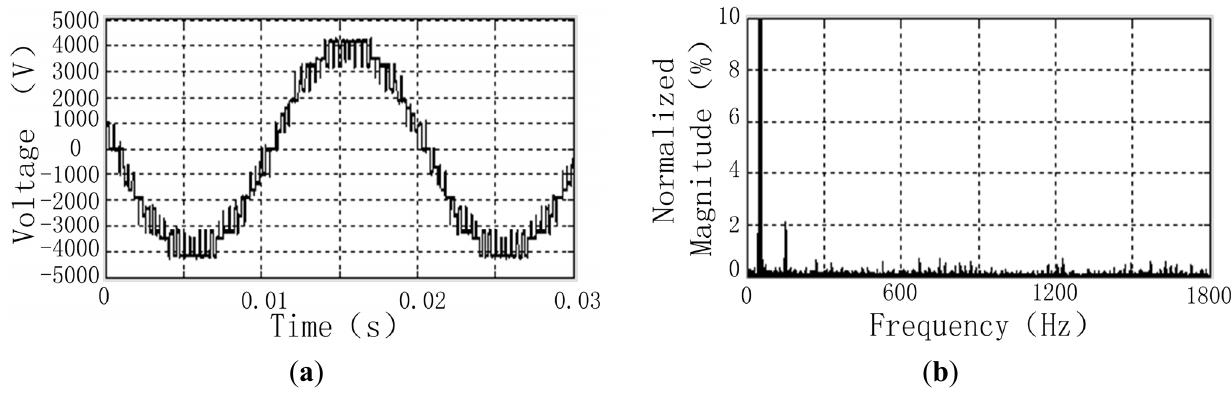
Figure 12. Result of the proposed PSCPWM when the second cell dc voltage is 690 V: ( a ) output voltage waveform; and ( b )